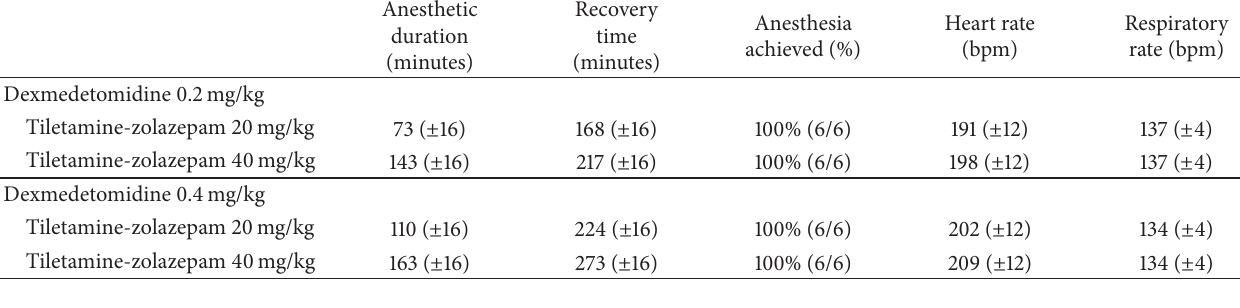
Table 4: Recommended dosages of dexmedetomidine, tiletamine-zolazepam, and butorphanol. Dosages recommended for use were determined based on anesthetic duration, induction, and recovery time, as well as safety, as measured by mortality. Increased dosages of dexmedetomidine and tiletamine-zolazepam resulted in an increasing trend of anesthetic duration and recovery times. Dexmedetomidine and tiletamine-zolazepam were administered IP and butorphanol was administered in all above listed trials at 3 mg/kg SC. Data are reported in predicted marginal means and standard error.